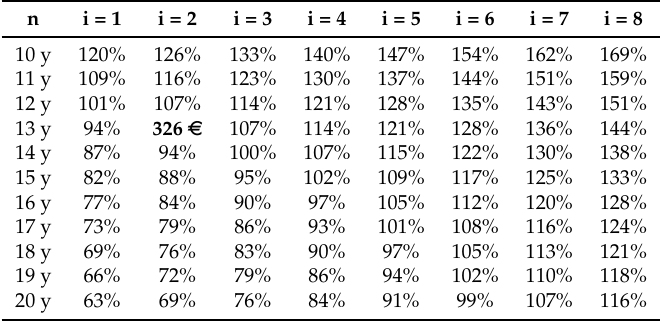
Table A6. BESS annuity sensitivity—Variation of interest rate and depreciation time of a BESS with 5 kWh compared to the initial values (n = 13, r = 2) (shown in